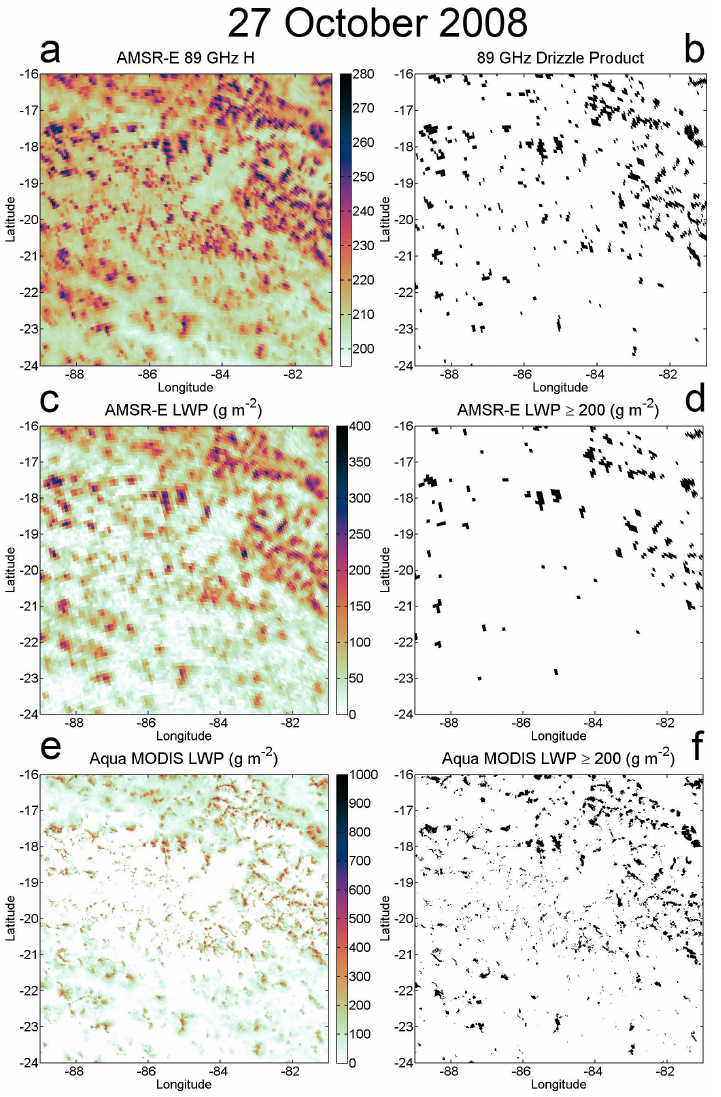
Fig. 5. Drizzle information for the southeast Pacific on 27 October 2008 at ≈ 19:35UTC. (a) is AMSR-E horizontally polarized 89-GHz brightness temperature from the L2A brightness temperature product. (c) is AMSR-E LWP from the L2 Ocean product. (e) is the Aqua MODIS daytime mean cloud water path from the MYD06 L2 product. (b) is the 89-GHz–based binary heavy drizzle classification field where black indicates drizzle. (d) is a binary field where black indicates AMSR-E LWP ≥ 200gm − 2 . (f) is a binary field where black indicates MODIS LWP ≥ 200gm − 2